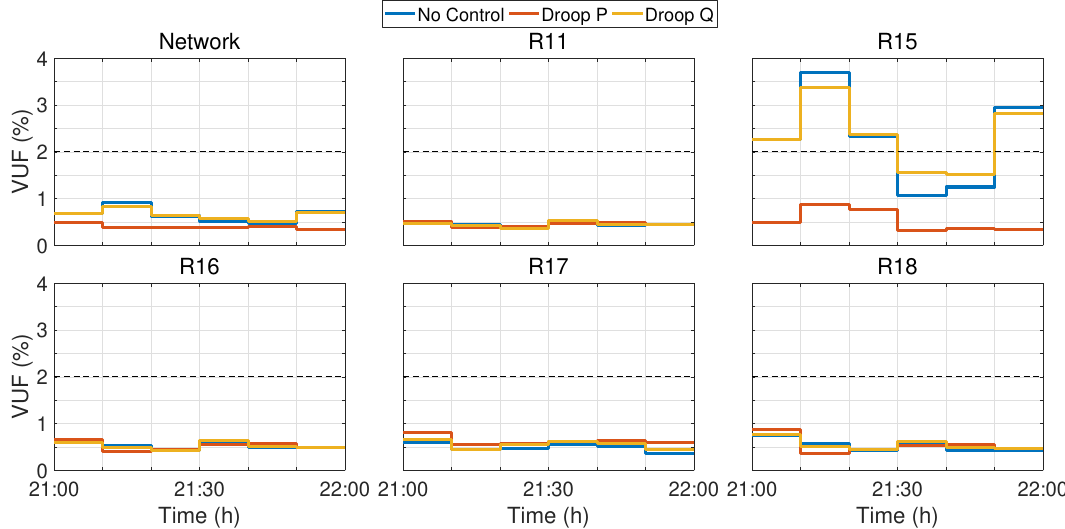
Figure 10. VUF for Scenarios I, II, and III.